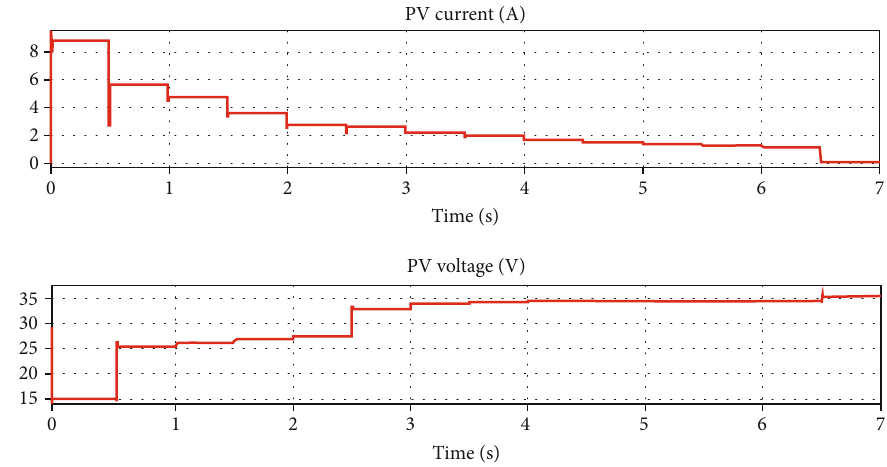
Figure 12: PVE current and voltage under 20% partially-shaded condition.